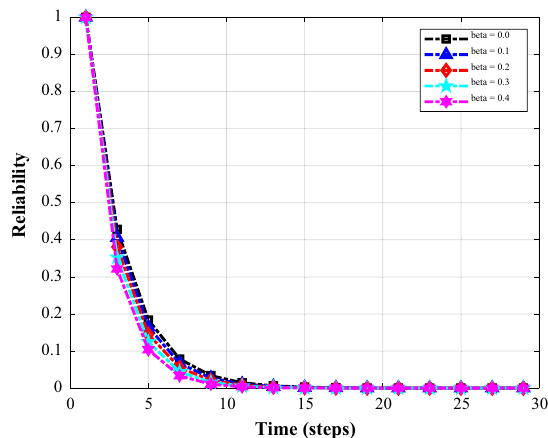
Fig. 15 Reliability performance at low system diagnostic coverage level and 50% repair efficiency